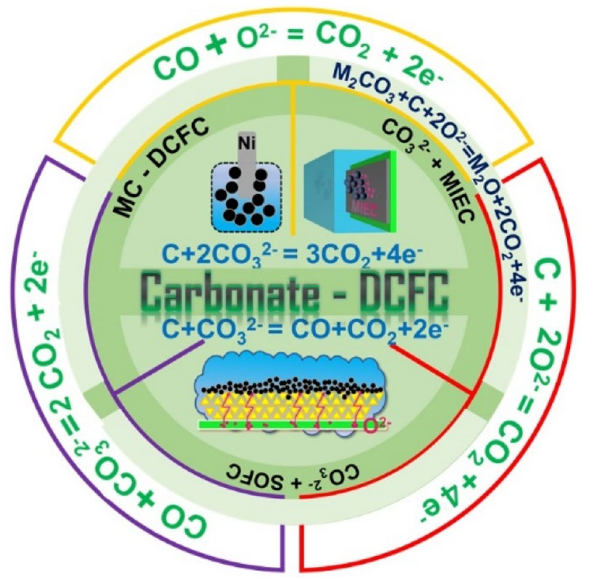
Fig. 1 Schematic of a DCFC in the presence of carbonate, including three cell systems (MC-DCFC, CO 32− + MIEC and CO 32− + SOFC) and some possible reactions. The primary reaction between carbon- ate and carbon is shown in light blue; the electro-catalytic reaction of carbonate with carbon is shown in dark blue; and the possible side reaction is shown in green